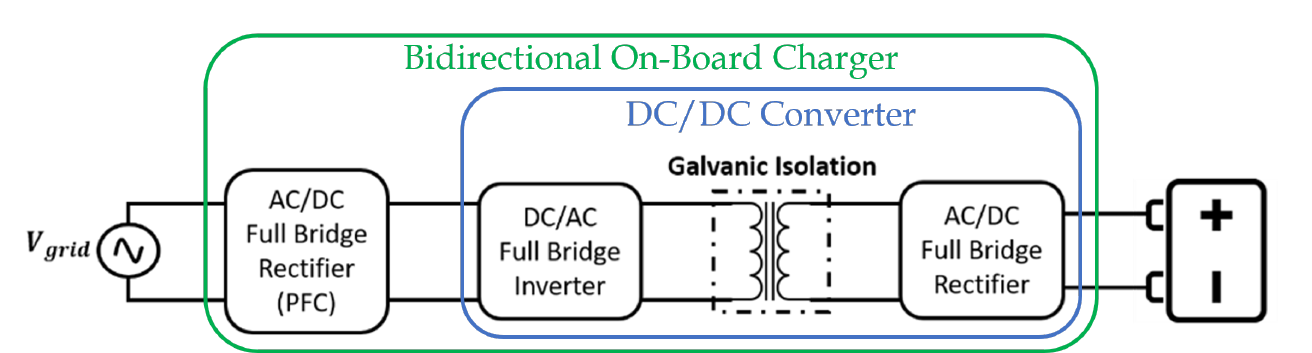
Figure 1. Schematic of the conversion stages of a bidirectional charger with galvanic isolation OBC.